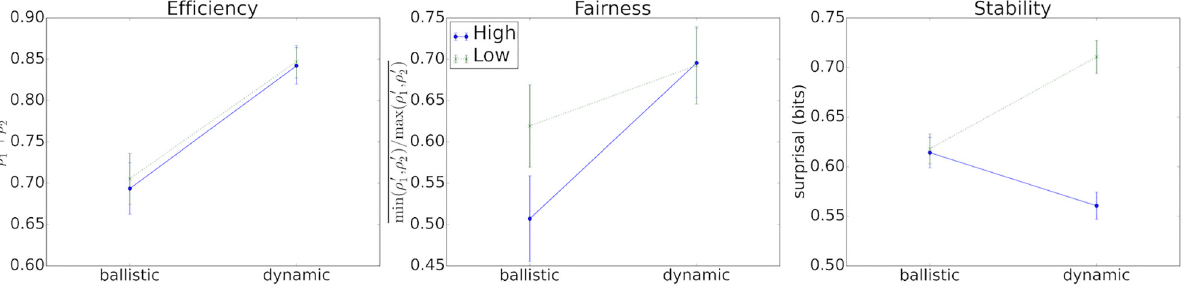
Fig 2. Main results at Binmore ’ s three levels of analysis. Bars reflect standard errors. Note that the results for the two dynamic conditions were the same by efficiency measures (a) and fairness measures (b), yet differed markedly in stability (c). Higher payoff differences increased stability (i.e. decreased surprisal) within the dynamic condition, but had no effect on stability in the ballistic condition. S3 Fig shows the same results using the less interpretable but more technically correct measure of “ mean rank ” on the